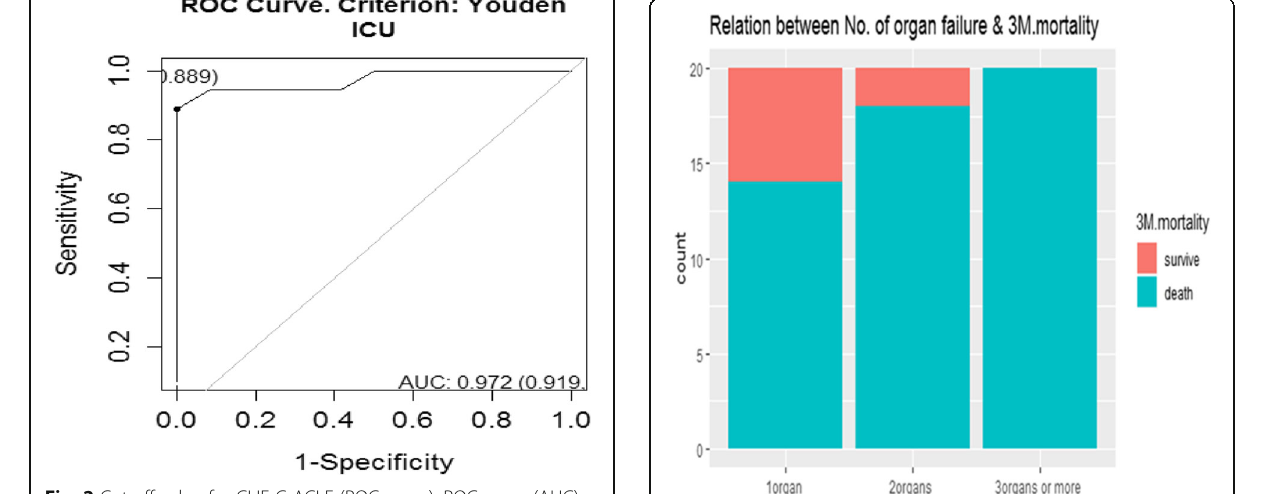
Fig. 2 Cut-off value for CLIF C ACLF (ROC curve). ROC curve (AUC): 0.972 with CI: 0.919, 1.025. Cutoff point = 57.0 above which intensive care admission does not seem to benefit ACLF patients. Optimal sensitivity at the actual cut point = 0.889 (88.89%). Optimal specificity at the actual cut point = 1.0 (100%)